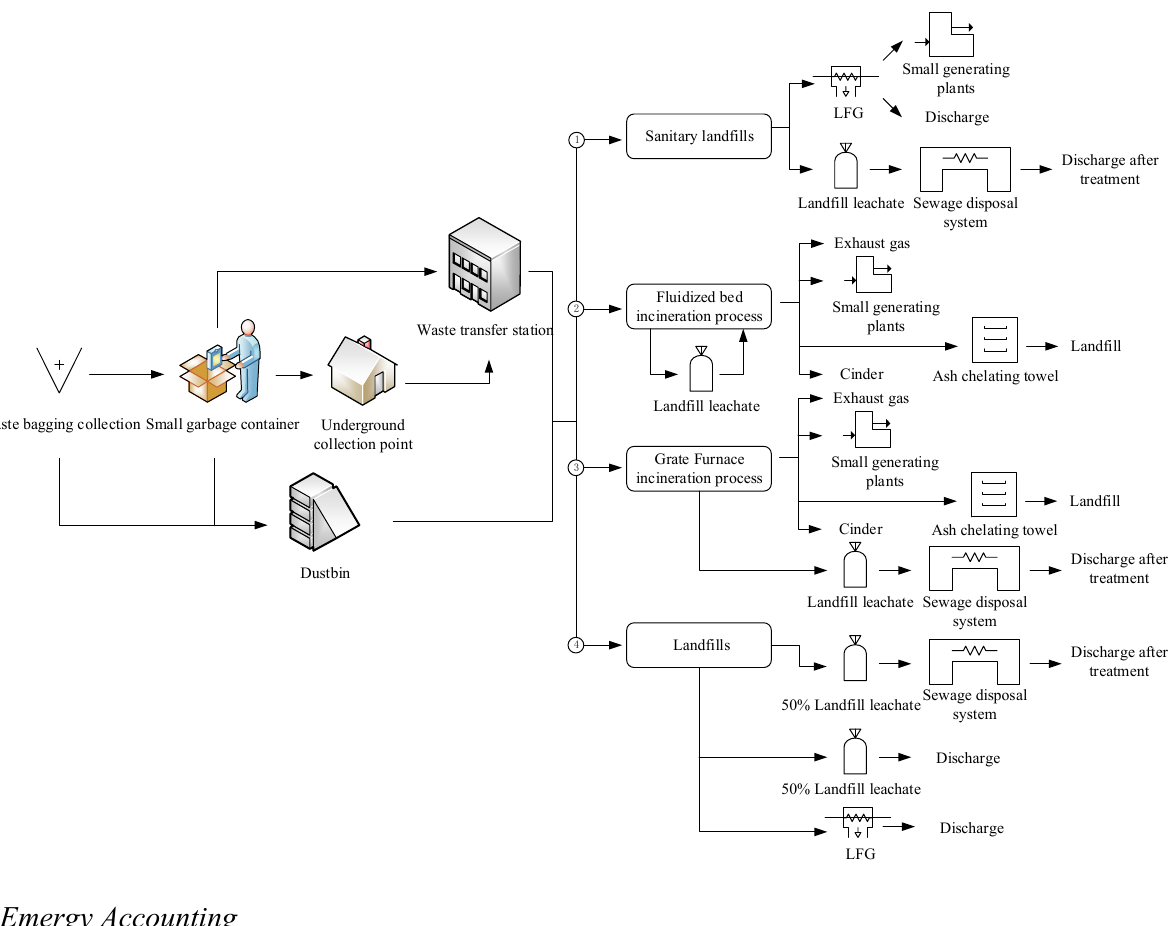
Figure 1. Flowchart of urban solid waste destinations in